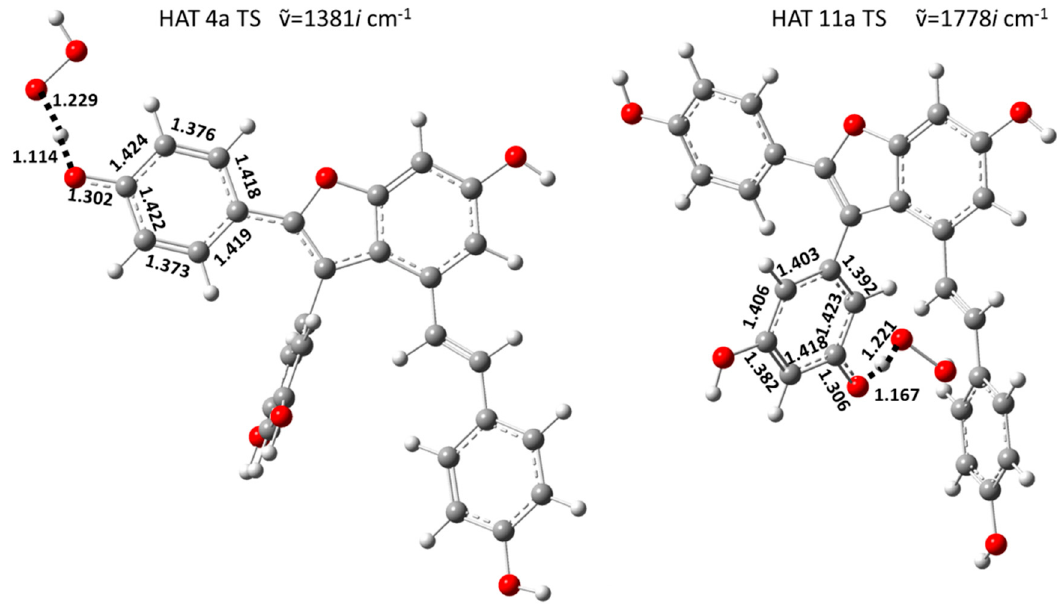
Figure 4. Cont Figure 4. Cont.